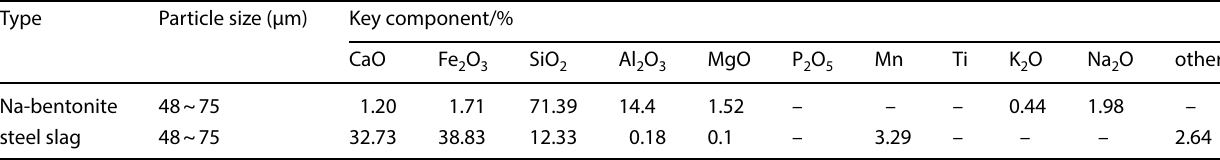
Fig. 1 Dynamic device diagram of three kinds of adsorbent materials